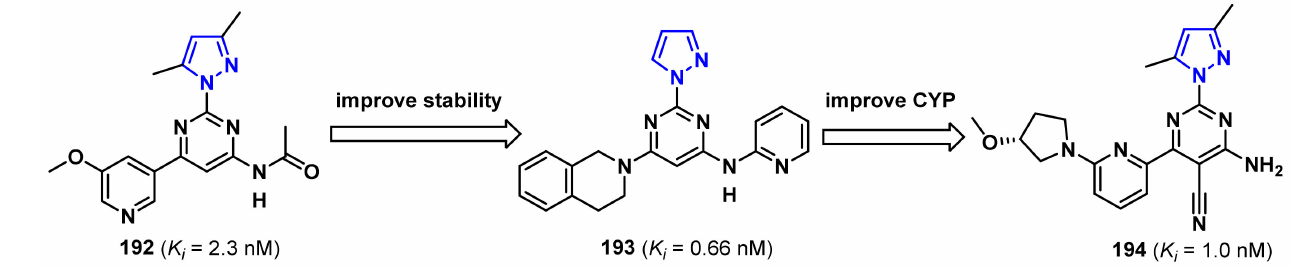
Figure 18. Chemical structures of pyrazole-containing A 2A receptor antagonists.